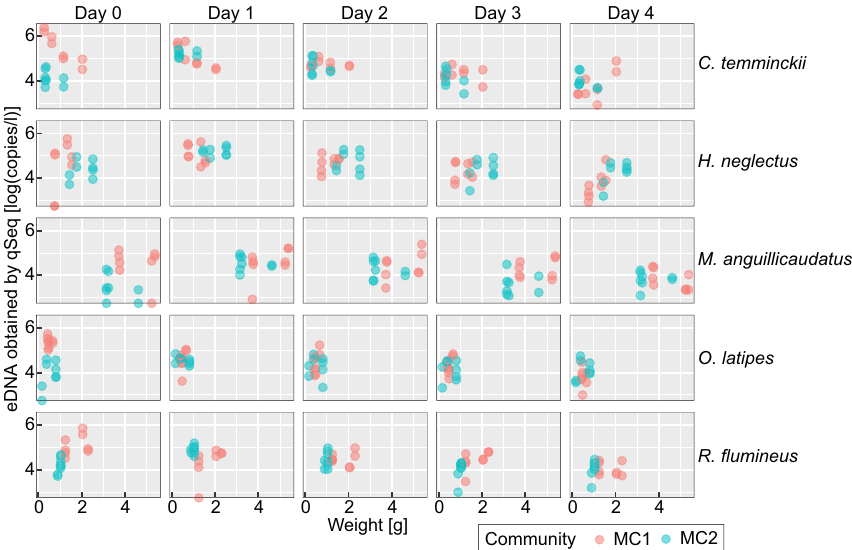
Figure 4. Correlation between biomass (fish weight) and the abundance of eDNA at all five time points quantified by qSeq.